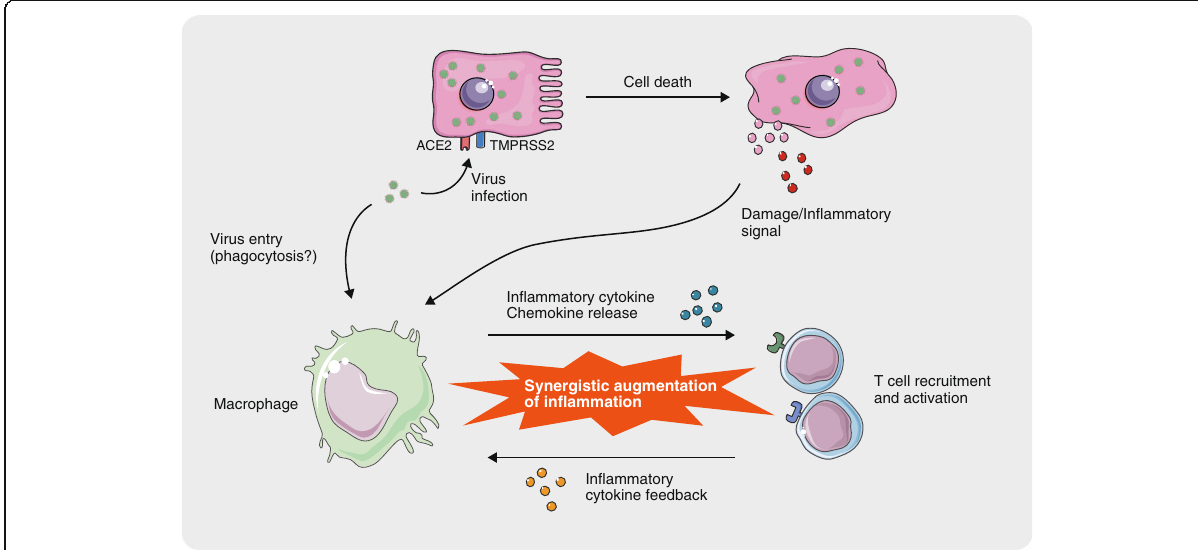
Fig. 1 Macrophage activation and its synergistic augmentation of inflammation in COVID-19. SARS-CoV-2 infects pneumocytes or enters macrophage. Infection-induced cell death promotes the release of damage signal molecules and inflammatory cytokines. Macrophages are activated upon inflammatory signal or viral genome entry then produce inflammatory cytokines and chemokines which recruit and activate T cells. Feedback inflammatory signals from T cells further activate macrophages. Synergistic augmentation of inflammation spread the entire lung and consequently systemic